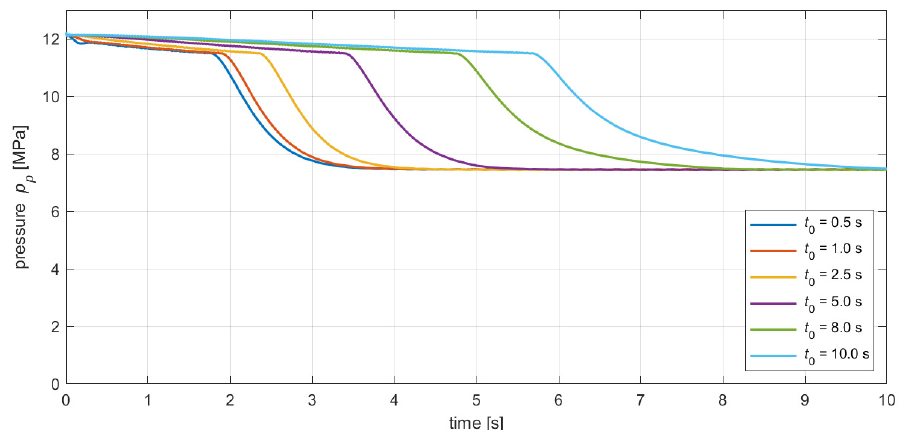
Figure 8. Result of simulation of the waveform of pressure on the pump p p for various signal rise times, t 0 .